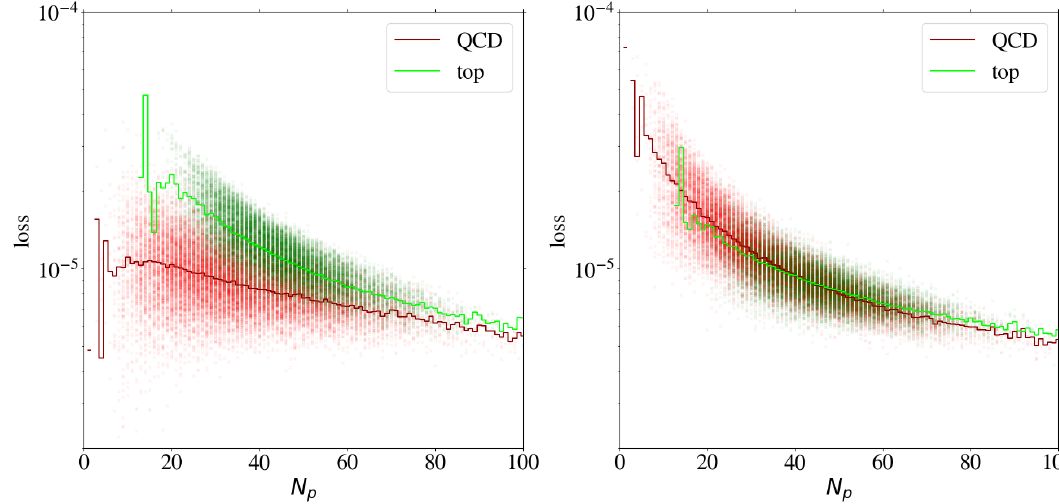
Figure 13 . Reconstruction loss of individual test jets (only half of the test set is shown as points in the scatter plot) as a function of non-zero pixels for an AE trained on QCD jets (left) and top jets (right) using the R 2 intensity remapping. QCD (top) jets are shown in red (green). The solid lines show the median loss for a given number of non-zero